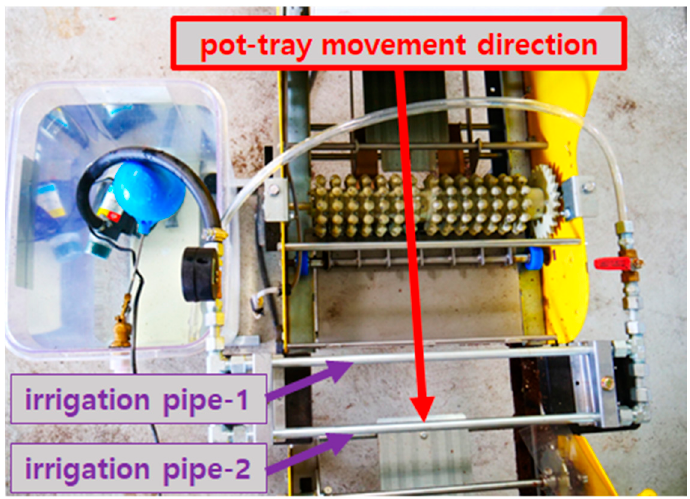
Figure 8. Numbering of irrigation pipes.